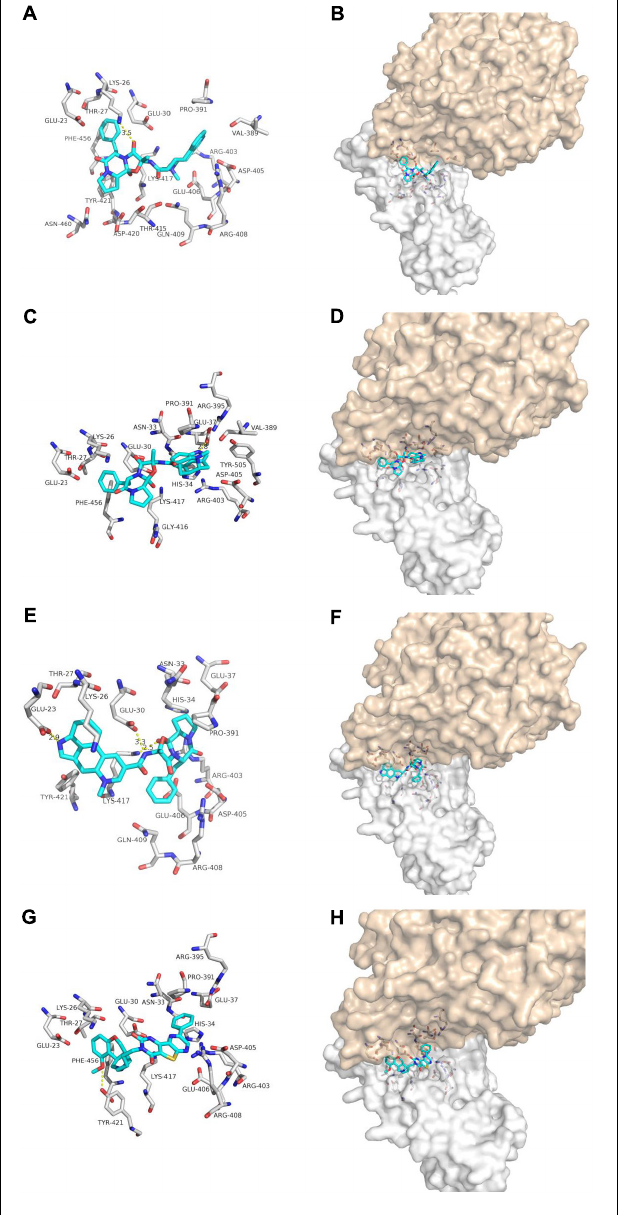
the interface of ACE2 and Spike glycoprotein complex. The interface between DDE and ACE2 and Spike glycoprotein complex maintains a hydrogen bond involving GLU-37 and Van der Waals energy. As for ergotamine, when